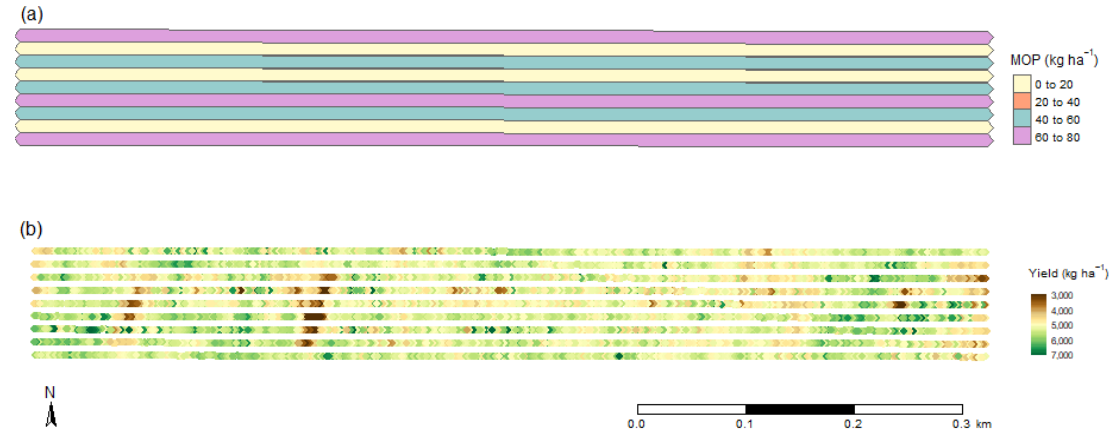
Figure 4. Cunderdin ( a ) trial design (kg Muriate of Potash (MOP) ha −1 ) and ( b ) cleaned yield data (kg ha −1 ).